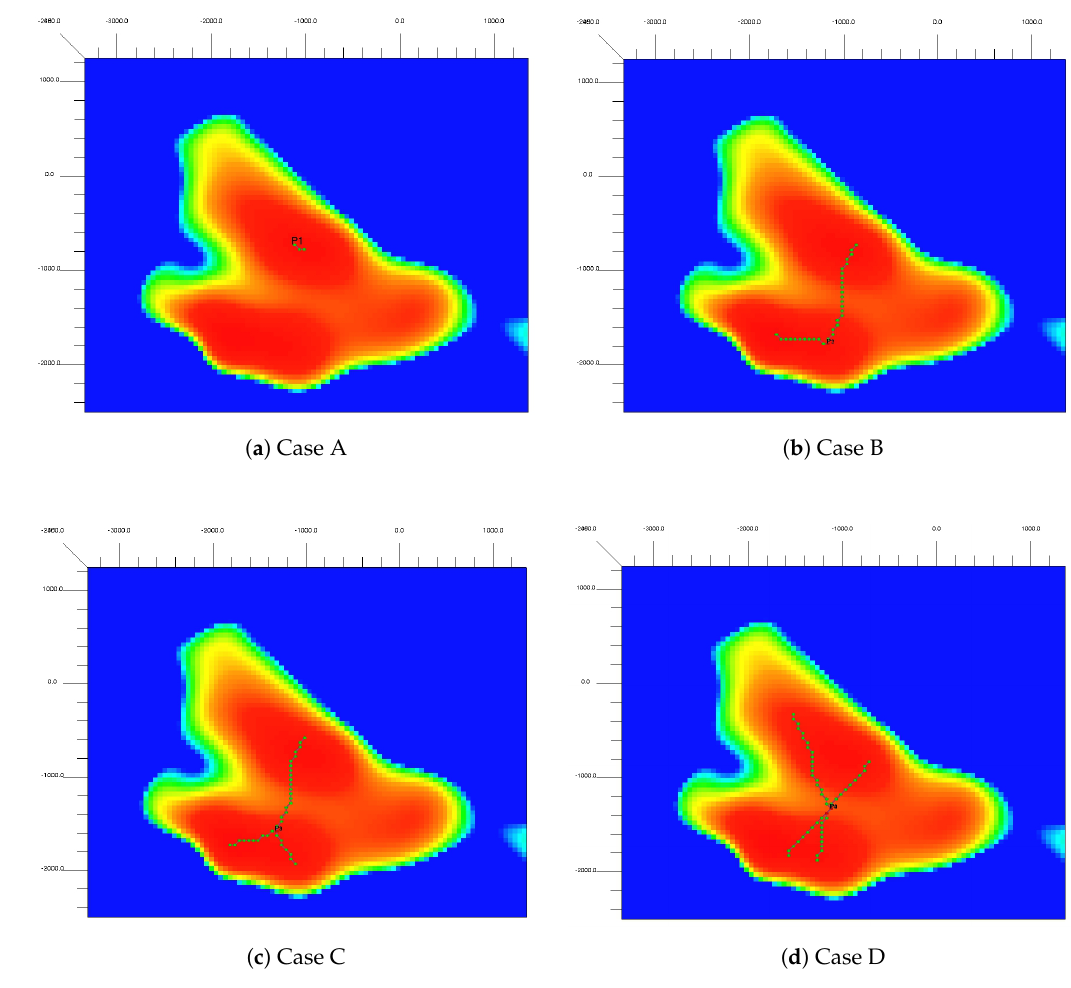
Figure 19. Multilateral well trajectories—optimal solution, PSO